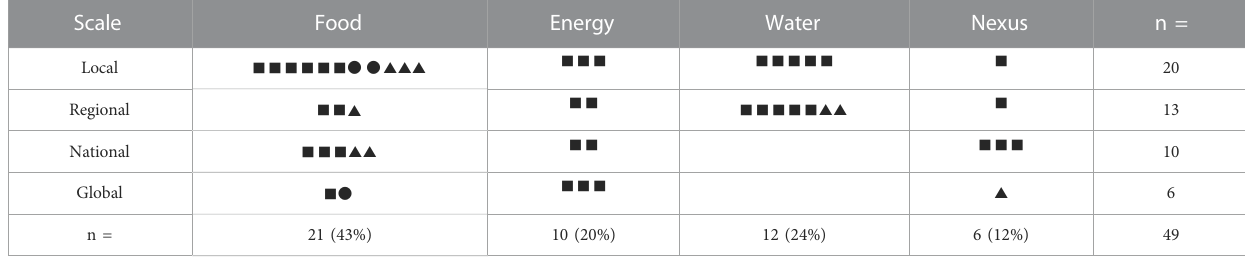
TABLE 1 Distribution of articles by FEWS focus (food, energy, water, nexus) and scale (local, regional, national, global). Each shape represents the methods used [square symbolusedtodenotequantitative methods,circle todenotequalitativemethods,andtriangletodenotemixed methods (quantitative andqualitative)]. The notation “ n = ” denotes the number and proportion of articles for each